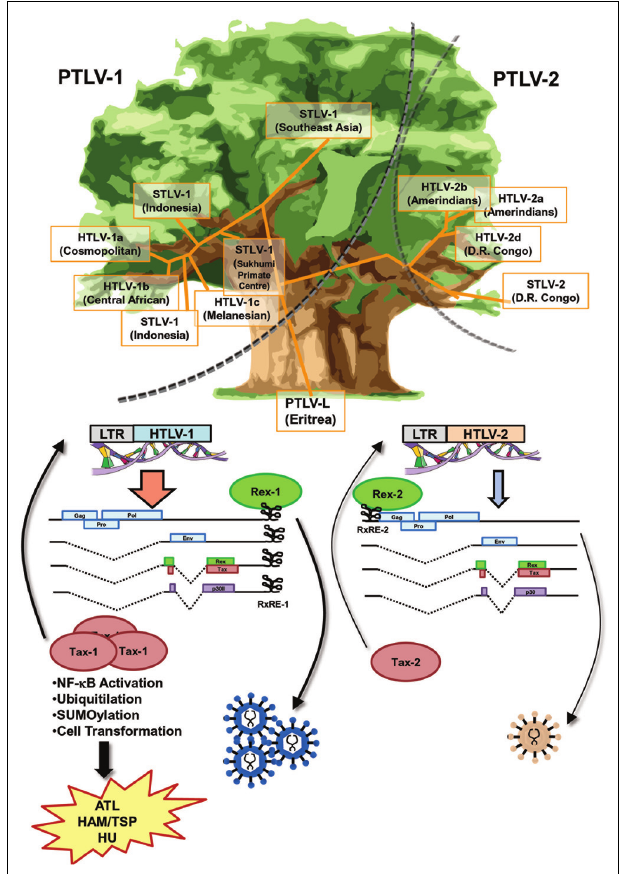
FIGURE 3 | Similarities and differences between Rex-1 and Rex-2. The phylogenetic tree of HTLV, which is drawn based on the report by Vandamme etal. (1998), shows that the major branches of PTLV-1 and PTLV-2 separated at an early stage. Sub-branches of STVL-1 and HTLV-1 or STLV-2 and HTLV-2 were separated within each major branch thereafter.Yet, the genomic structures of HTLV-1 and HTLV-2 are very similar and both viruses encodeTax and Rex, the major transcriptional and post-transcriptional regulators, respectively. BothTax-1 andTax-2 have NLS, NES, and ATF/CREB binding domains, whereas onlyTax-1 has a distinct NF- κ B activating domain and p300 binding domain, as well as a number of PTM sites, for phosphorylation, ubiquitination, and SUMOylation, resulting in stronger transactivation and transforming activities than those ofTax-2. Both Rex-1 and Rex-2 are phosphoproteins sharing 60% similarity with overlapped major functional domains, such as NLS, NES, and SD at the 3 (cid:2) -terminus.The RxRE motif of HTLV-1 mRNA (RxRE-1) is located in the U3/R region and all HTLV-1 mRNA have intact RxRE-1s in the 3 (cid:2) UTRs. On the other hand, the RxRE of HTLV-2 (RxRE-2) is located at the R/U5 region and only unspliced mRNA maintains the intact RxRE-2.Thus, Rex-1 is capable of transporting all viral mRNA including tax/rex mRNA and enhancing the expression ofTax for further transactivation of LTR, whereas Rex-2 is not. Overall, Rex-1 may have a stronger impact on viral replication through the enhancement ofTax-1 expression compared with Rex-2. Different roles ofTax and Rex may be related to the differences in pathophysiologies of HTLV-1 and